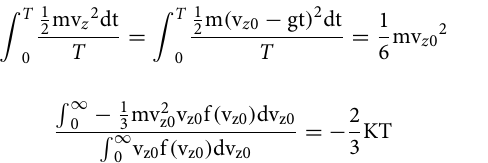
Table 1. Temperature drops at various heights compared to the 10 cm height position and the drop rates for the insulated air column of 60 cm diameter under gravity.